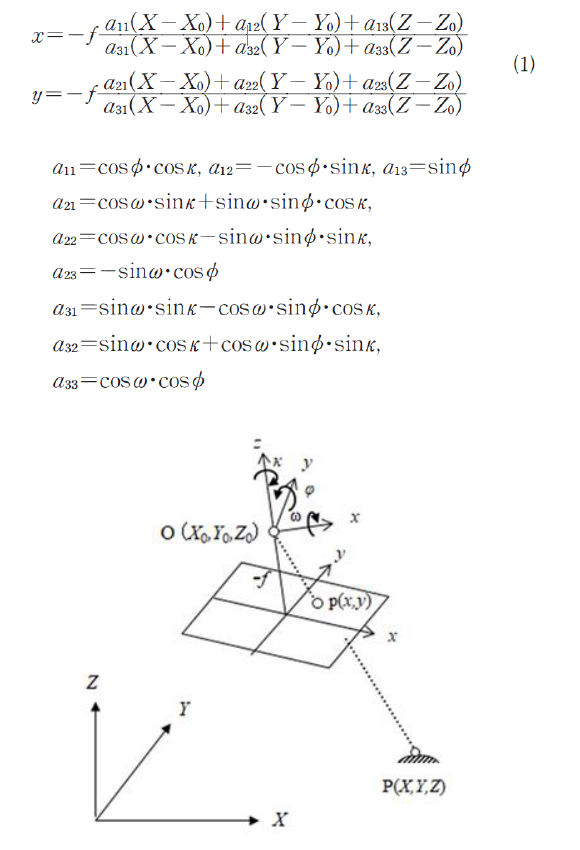
Figure 5 . Geometry in photogrammetry. If the camera is calibrated in advance, a ij , X 0 , Y 0 , Z 0 , and f in Equation (1) will be known values. However, even if the camera is not calibrated, if the camera parameters (focal length, image size, and sensor size), approximate tilt of the camera (ω), and height of the imaging point (Z 0 ) can be estimated, the proposed method can be implemented under the assumption that the other parameters are